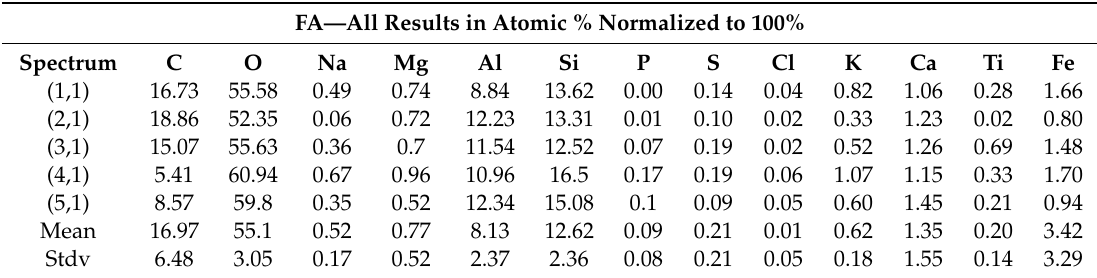
Table 5. SEM / EDX counts summary (% atomic) of Table 5. SEM/EDX counts summary (% atomic) of FA.